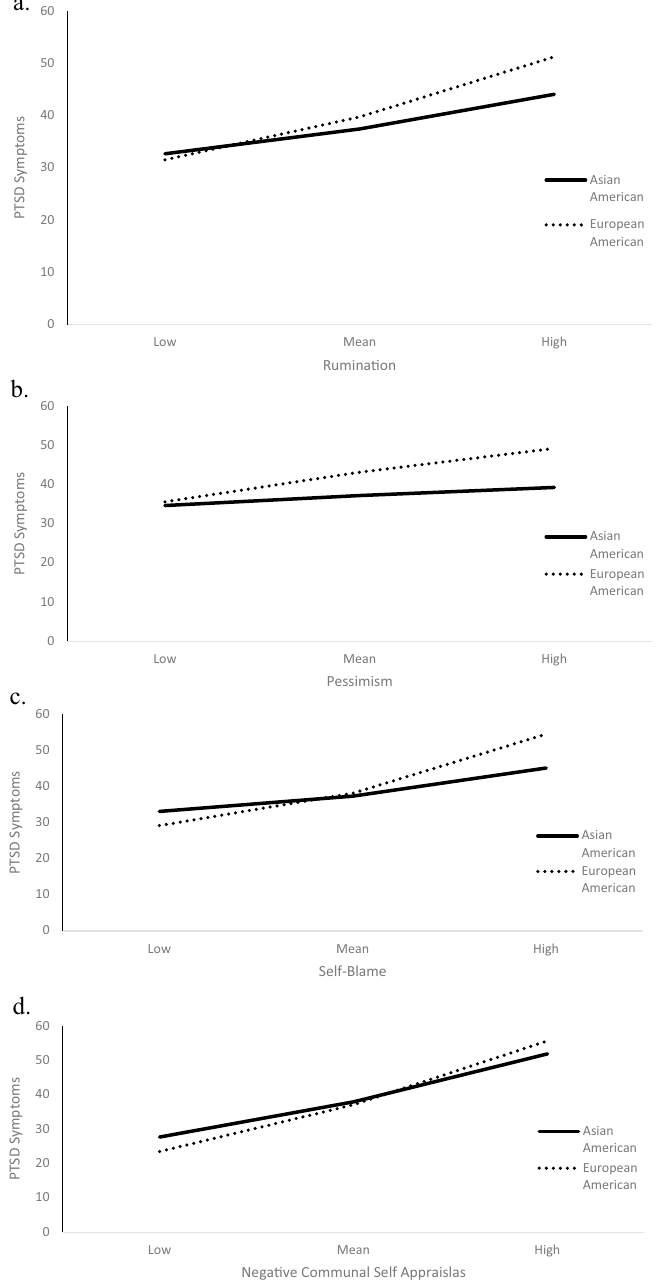
(pessimism) than the European American group. In support of Hypothesis 2, the associations between rumina- tion and PTSD symptoms and between self-blame and PTSD symptoms were large for the European American group, but weaker for the Asian American group. In contrast to our hypothesis, the associations between fatal- ism (pessimism) and negative communal self-appraisals and PTSD symptoms were also larger for the Euro- pean American group than the Asian American group. Finally, there was mixed support for Hypothesis 3. We found that, as predicted, there was a significant indirect pathway between independent self-construal and PTSD symptoms through psychological inflexibility (European American group only), brooding rumination (European American group only), primary control appraisals and negative self-appraisals. There was also a significant indirect pathway between interdependent self-construal and PTSD symptoms through emotional control, interpersonal emotion regulation, fatalism appraisals (European American group only), cultural beliefs about adversity, and cognitive appraisals about communal and social aspects of self. However, contrary to that